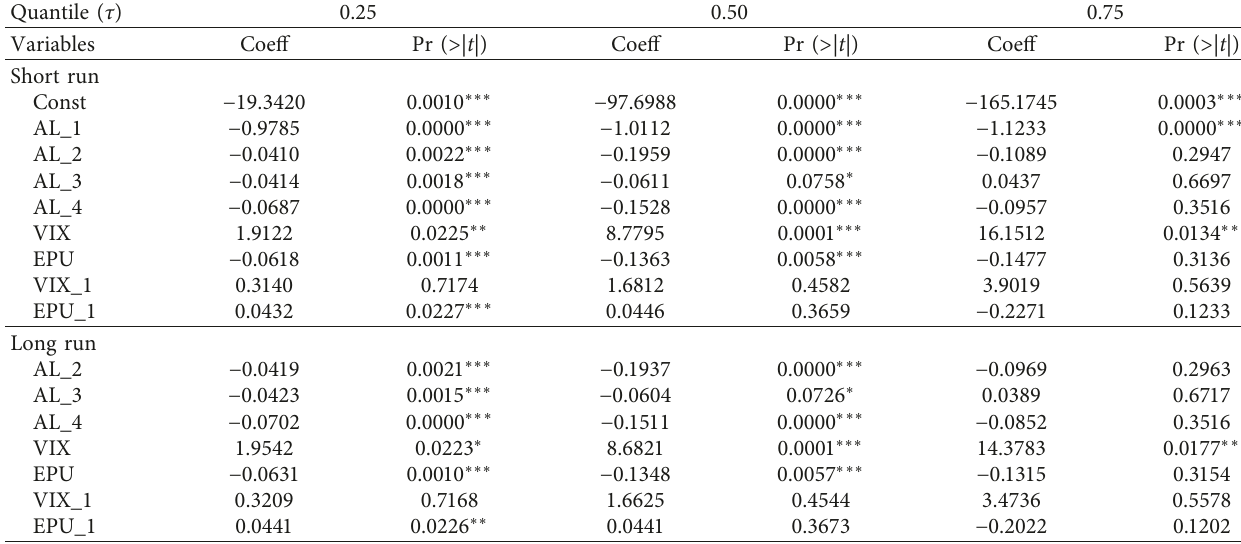
Table 7: QARDL estimation results: tranquil period (independent variables: EPU and